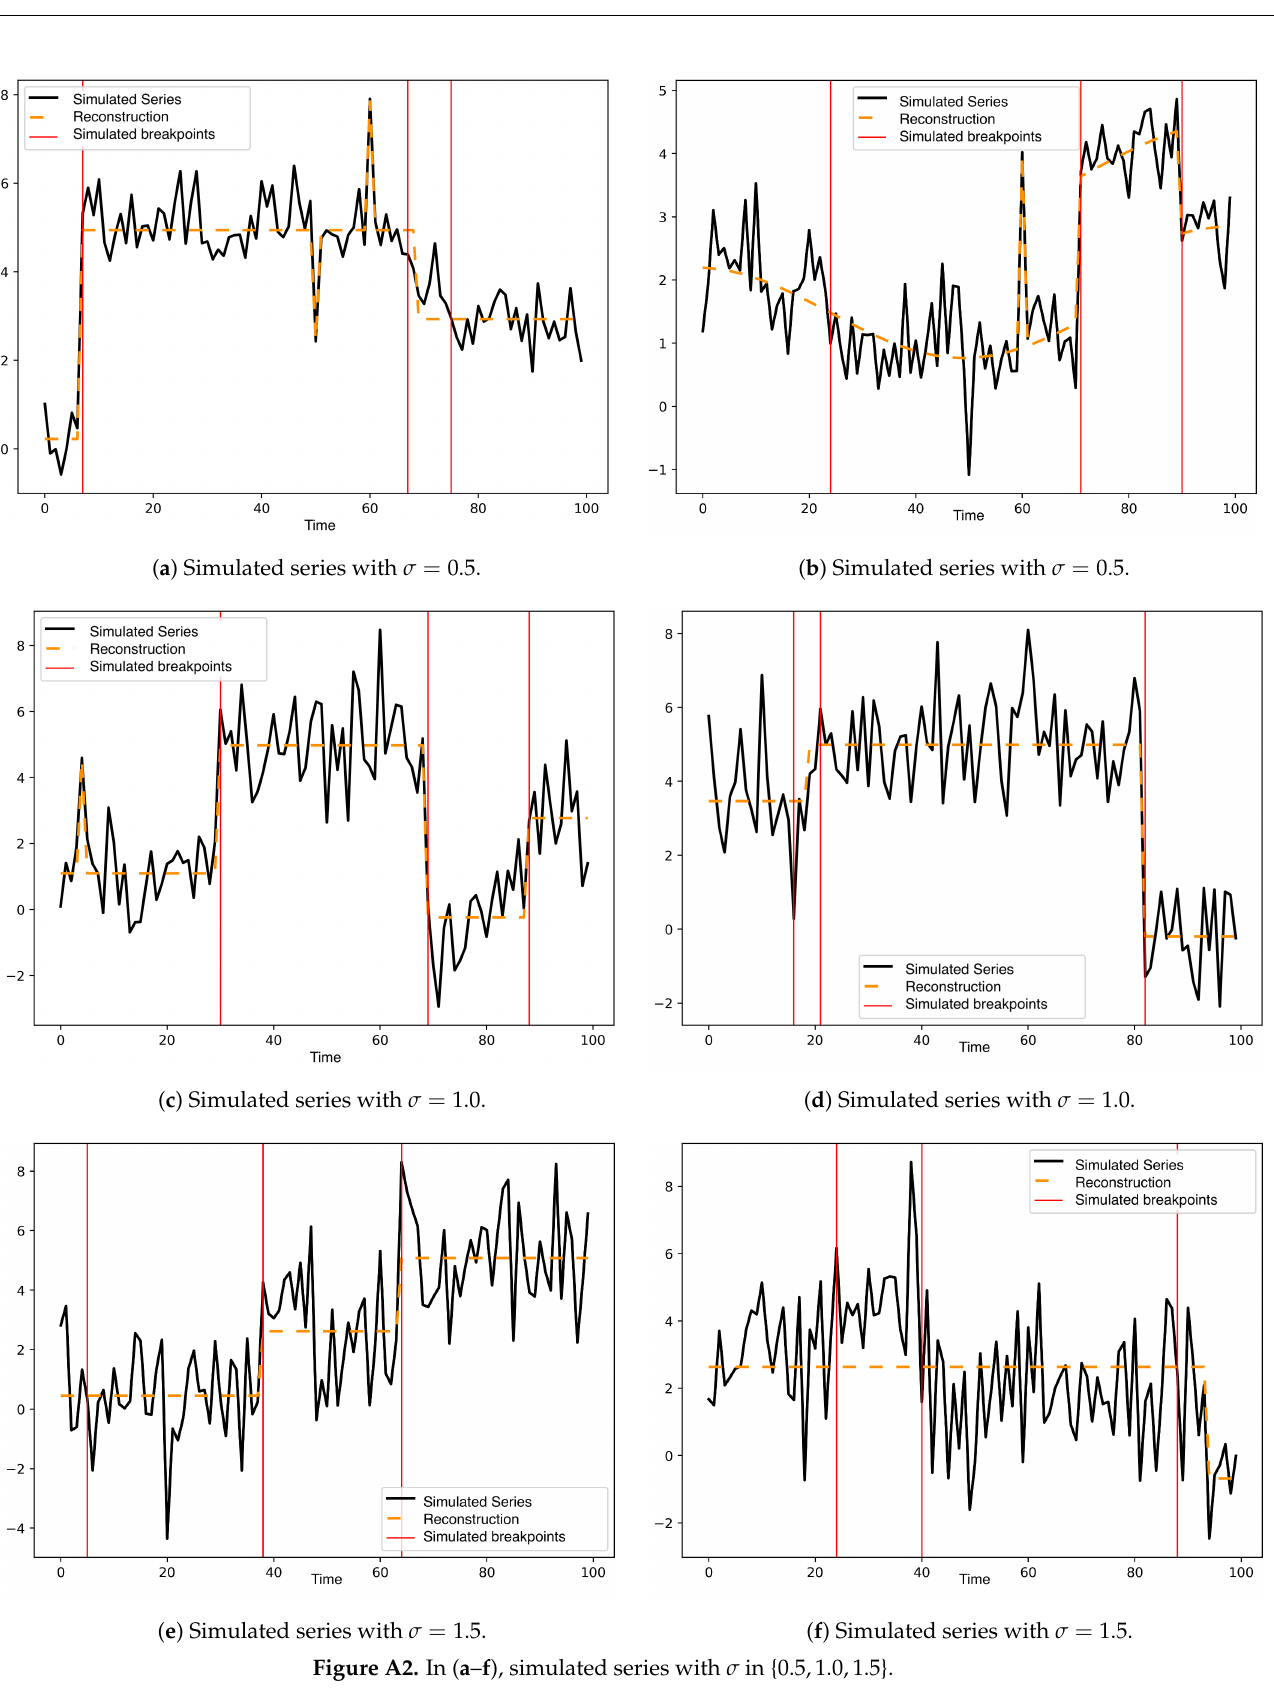
Figure A2. In ( a – f ), simulated series with σ in